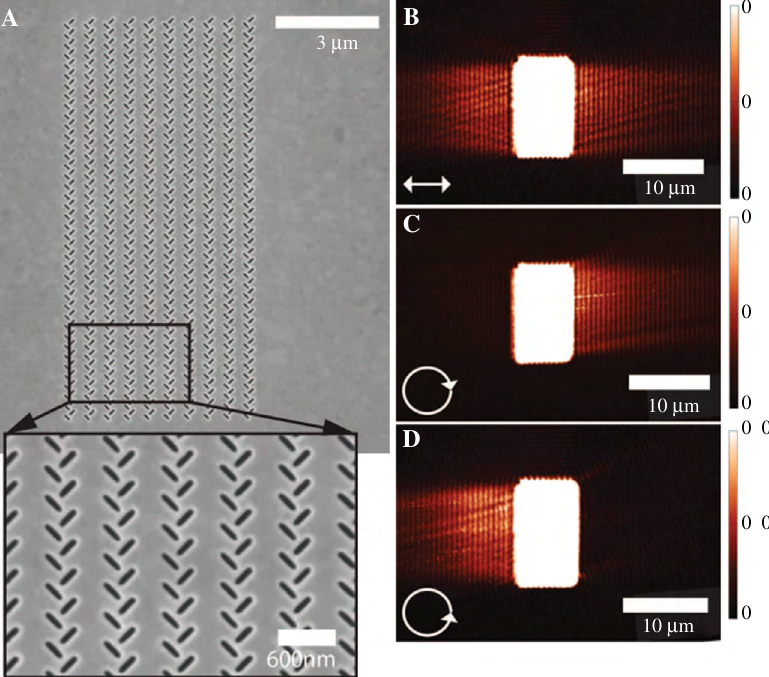
Figure 19 (A) SEM image of an array consists of multiple parallel column pairs of subwavelength apertures. NSOM images of the structure under illumination from the back by (B) linearly (C) RHC and (D) LHC polarized light. The state of incident polarization is indicated by white arrows. Adapted from Ref.